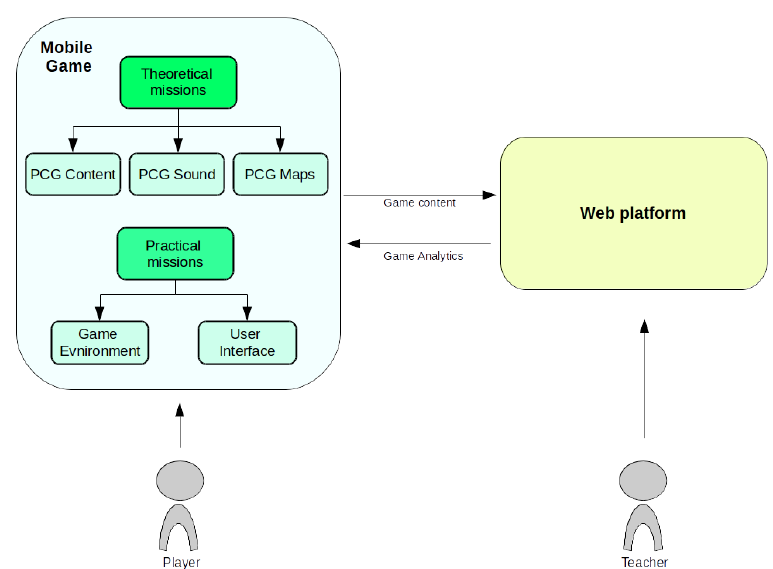
Fig. 1. sCool – Conceptional Architecture adapted after